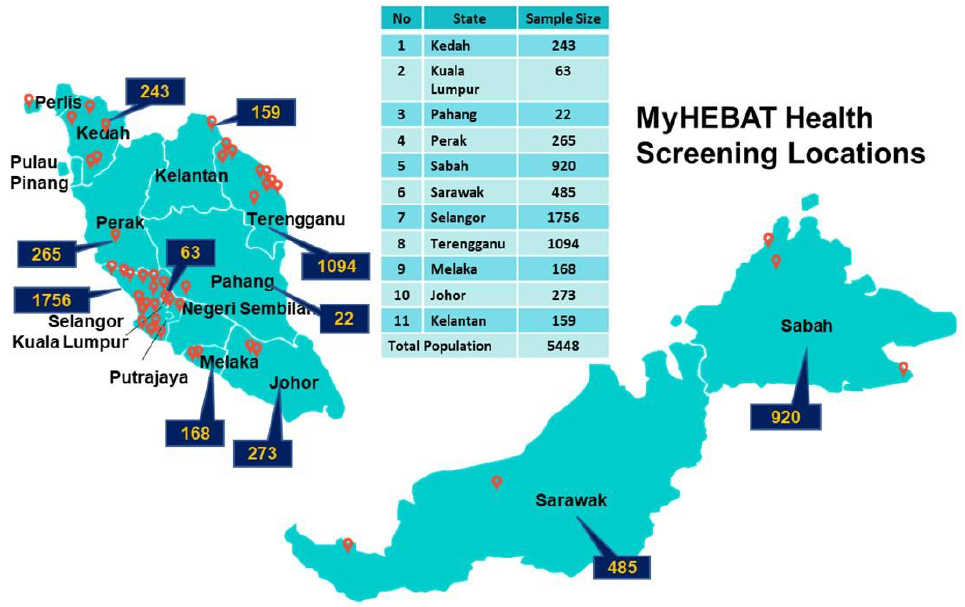
Figure 1. MyHEBAT health screening locations according to states. The figure indicates the locations and numbers of participants recruited throughout Malaysia.